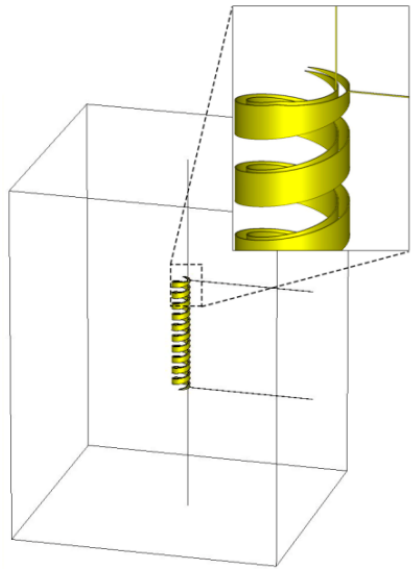
Figure 14. Tape-coil FEM model.